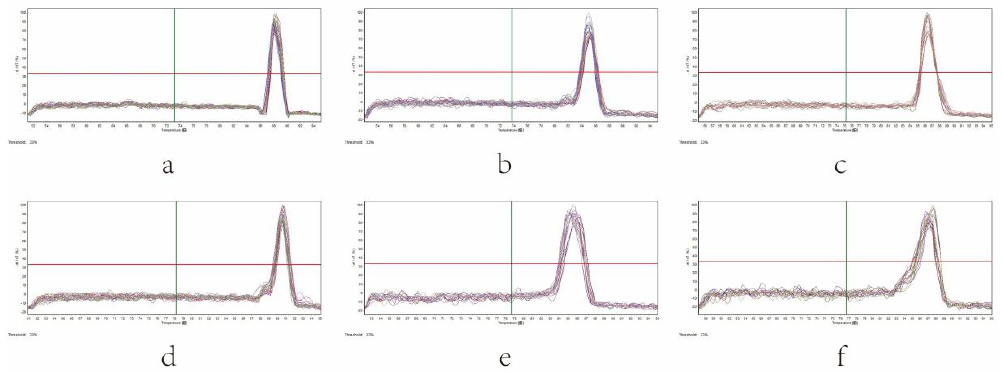
Figure 4. Melting curve of intestinal microbiota in different groups of rats by real-time q-PCR. ( a ) Escherichia coil , ( b ) Enterococcus , ( c ) Lactobacillus , ( d ) Bifidobacterium , ( e ) Bacteroides fragilis , ( f ) Clostridium tender .